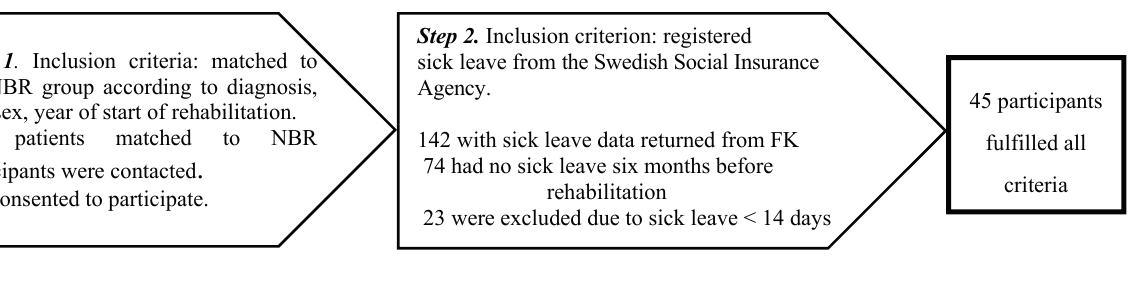
Figure 2. The recruitment process for the OHS group and the inclusion criteria connected to each